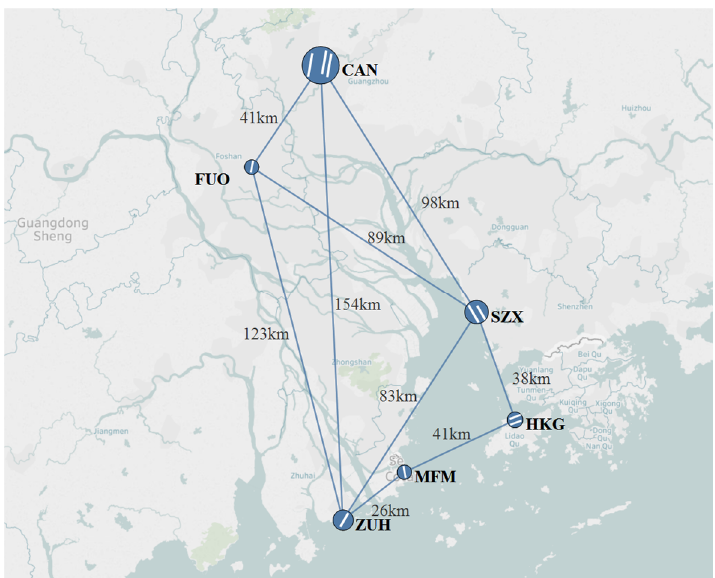
Figure 3. The Greater Bay MAR.